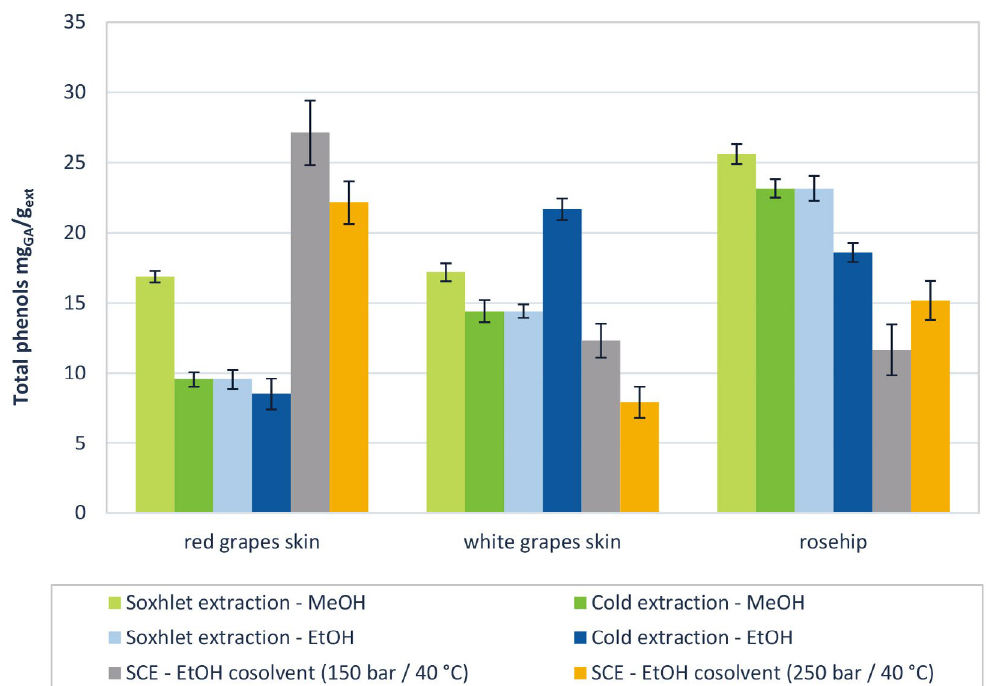
Figure 2 : Comparison of total phenolic content, expressed as mg of gallic acid/g of extract (mg GA /g EXT ) at different extraction